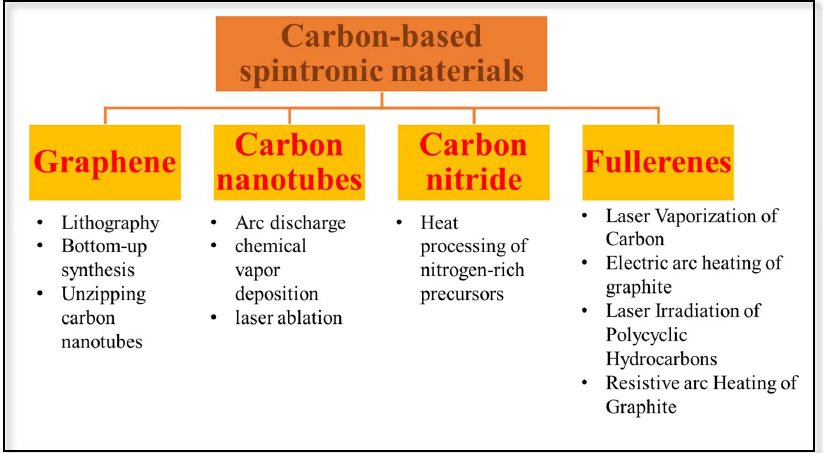
Figure 3. Schematic representation of the preparation of carbon-based spintronic